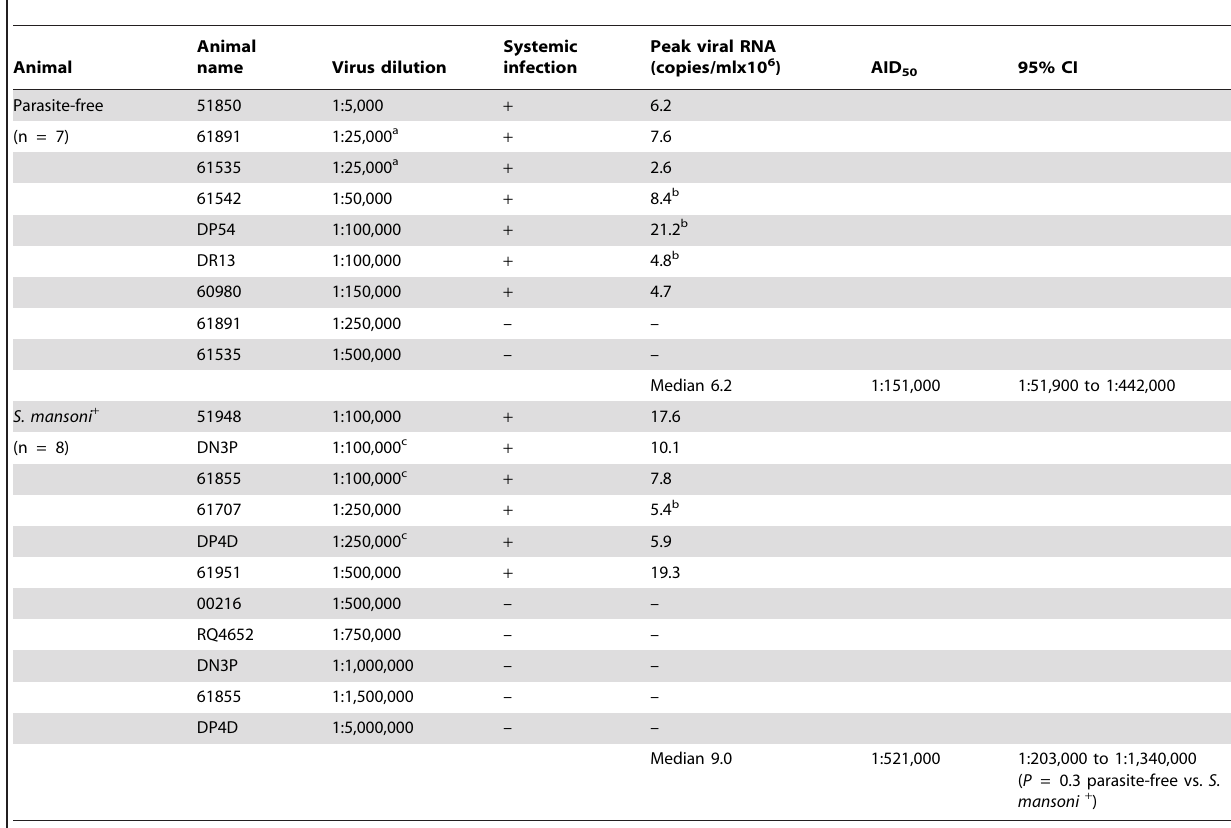
Table 1. Intravenous titration of